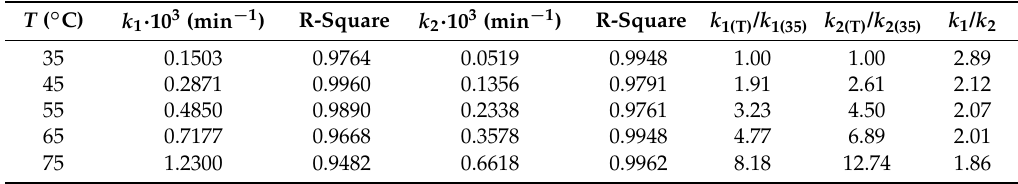
Table 1. Rate constants for the polymerization of HTPB-IPDI system at different isothermal curing temperatures in the presence of TECH (0.1 wt %) as catalyst.